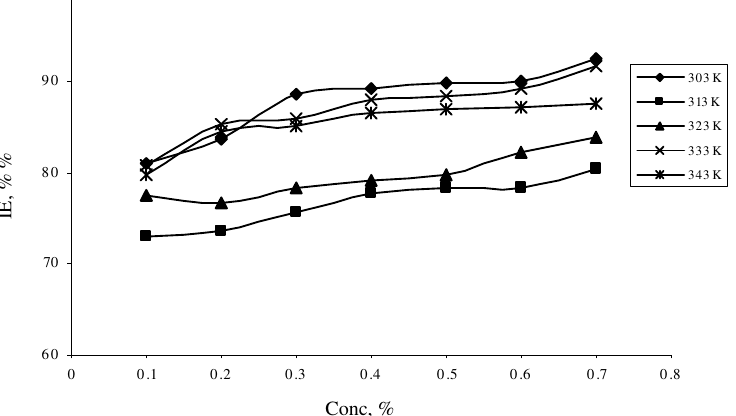
Figure 2 . Effect of temperature on the corrosion inhibition of mild steel in the presence of CT extract in 1 M HCl